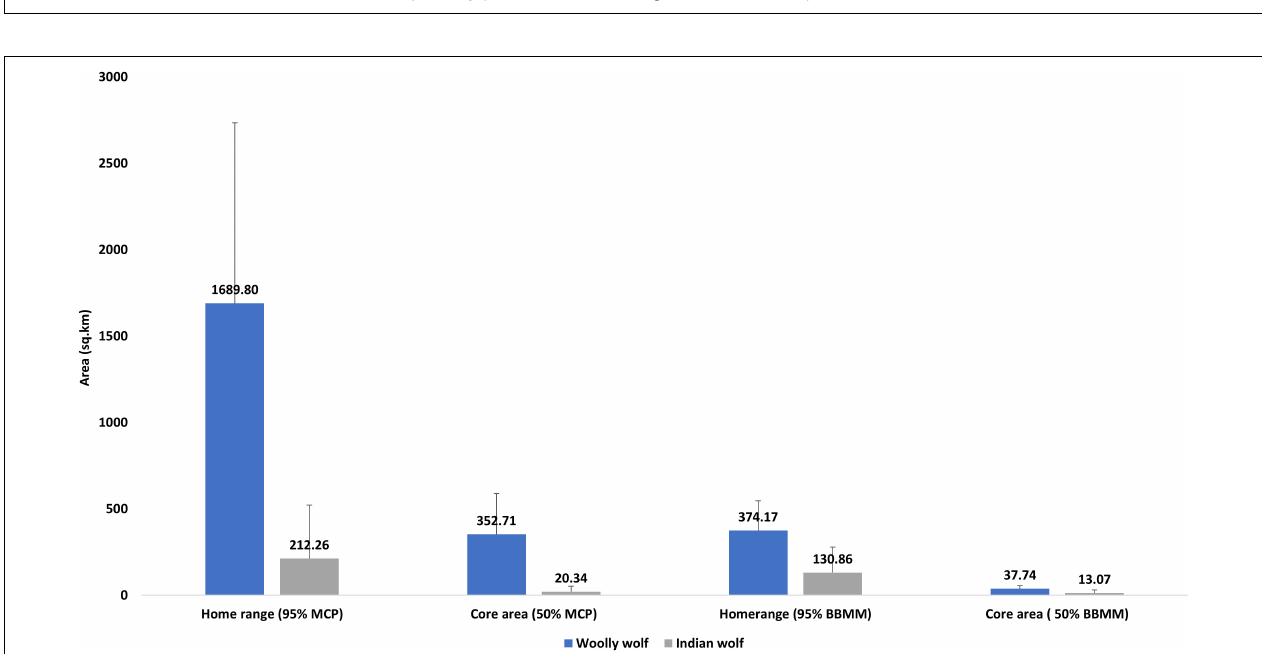
FIGURE 3 | Comparison of the home ranges (95% MCP and BBMM) and core area (50% MCP and BBMM) used by the Woolly and Indian wolf (MCP; minimum convex polygon; BBMM: brownian bridge movement model).